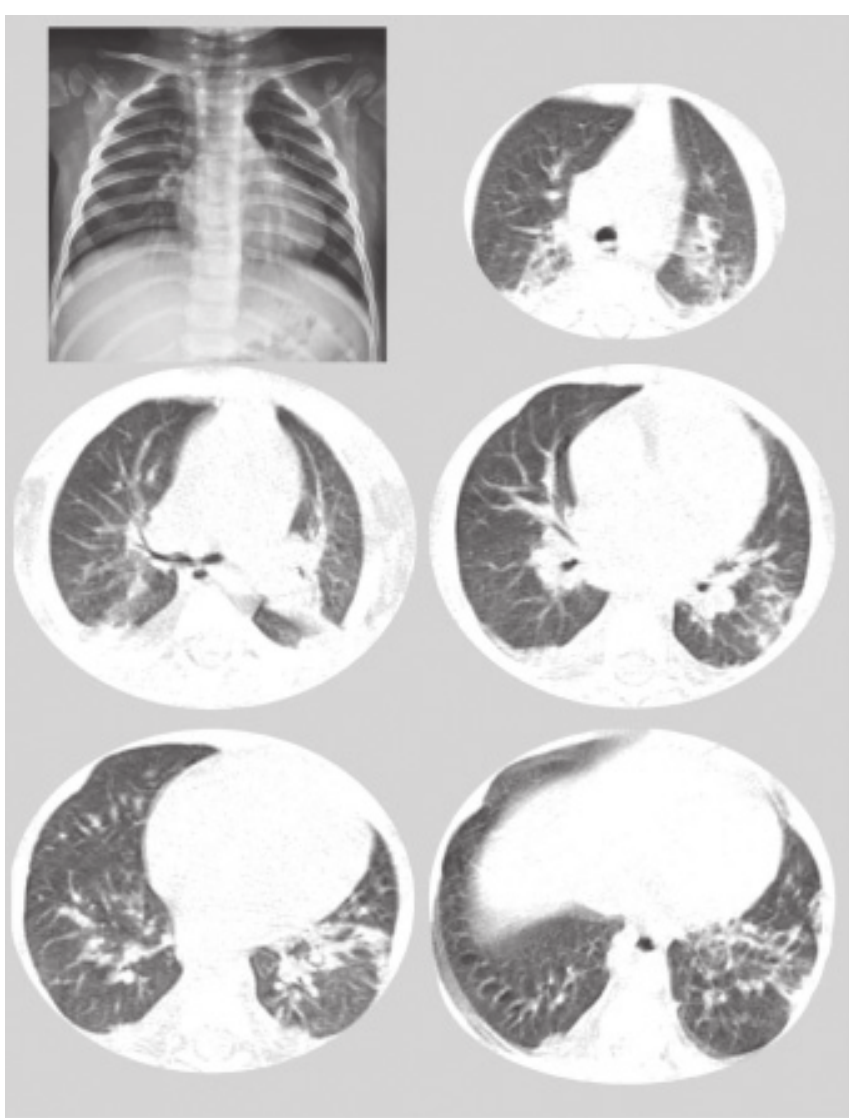
Figure 1: Chest X-ray and CT scan on the 3 rd day of admission show bilateral ground-glass